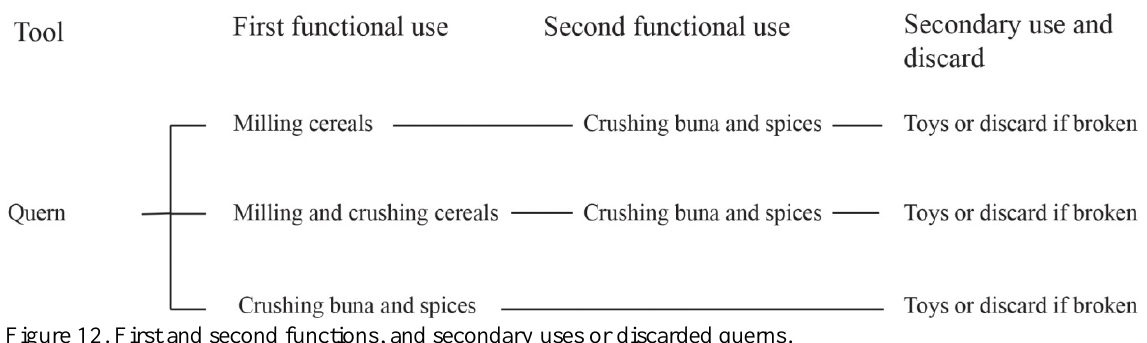
Figure 12. First and second functions, and secondary uses or discarded